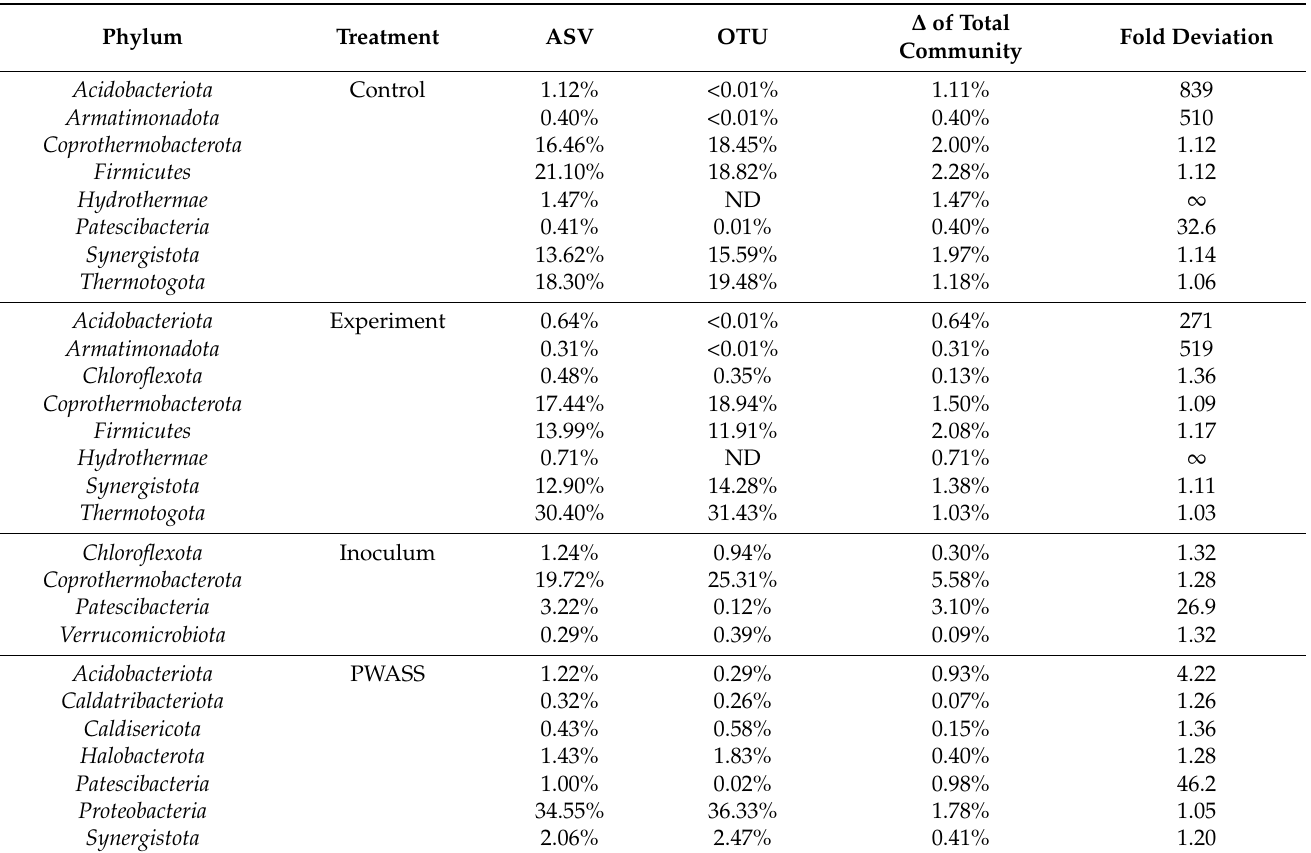
Table 2. Phyla differences based on choice of